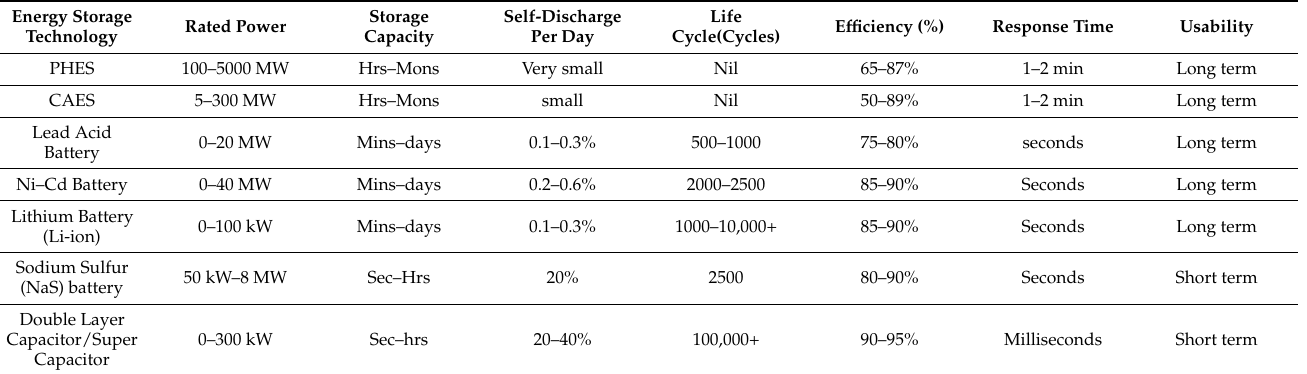
Table 3. Characteristics of energy storage technologies and